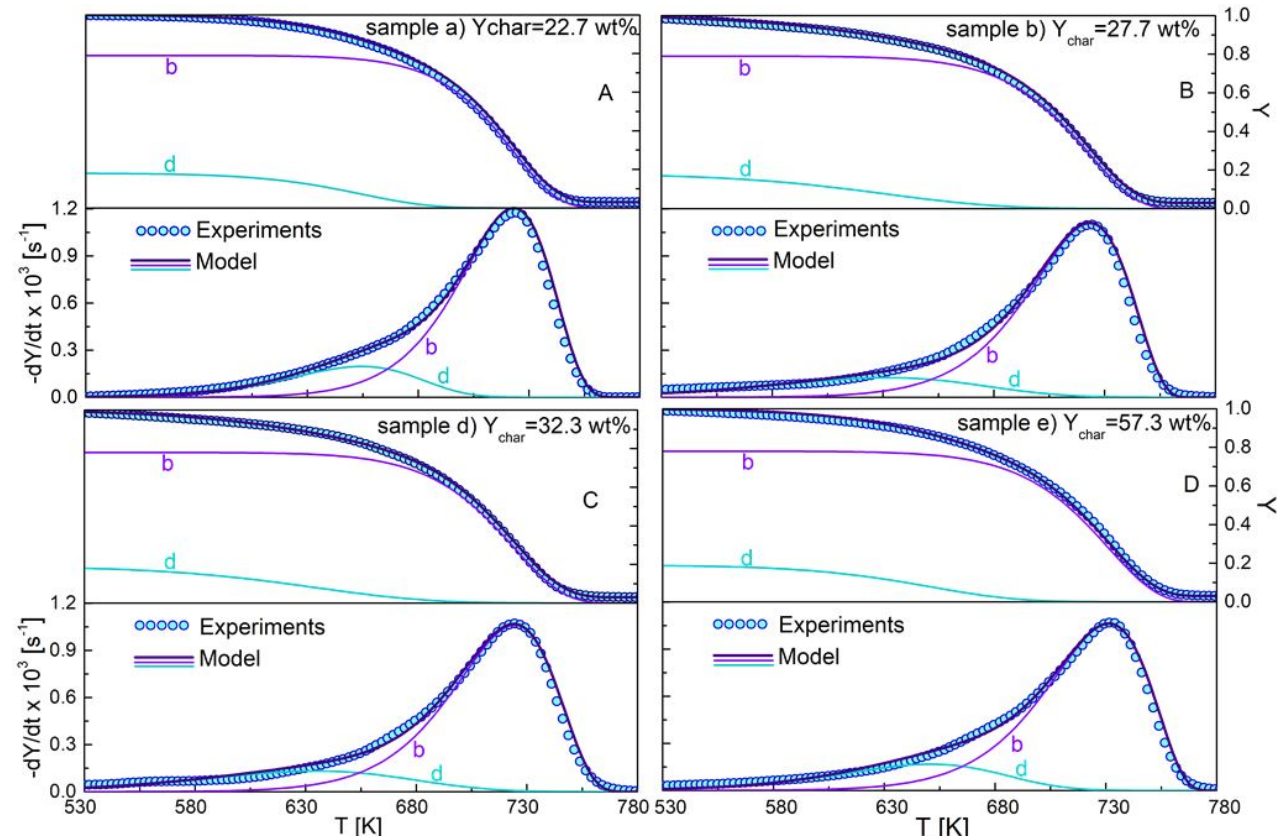
Figure 6. Weight loss curves (Y) and devolatilization rate curves ( − dY/dt) for the pyrolysis chars samples a ( A ), b ( B ), d ( C ) and e ( D ) (torrefaction conditions in Table 1) versus temperature, as measured (symbols) and predicted (solid lines) (including the prediction for the devolatilization (d) and oxidation (b) reactions).